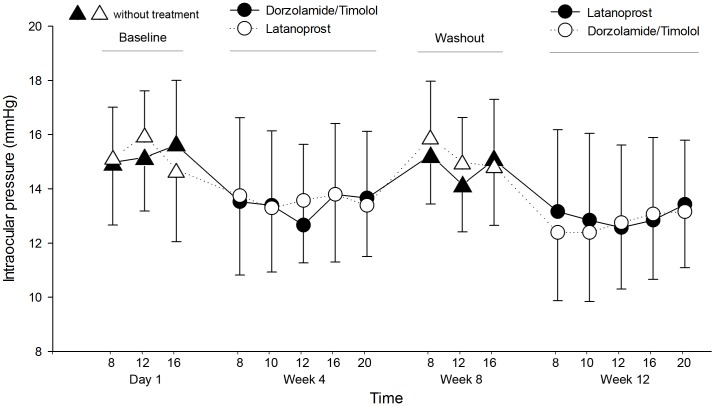
Mean intraocular pressure during the circadian curve for the three crossover phases: at baseline, after dorzolamide/timolol, and after latanoprost.Vertical bars indicate the 95% confidence interval of the estimates.